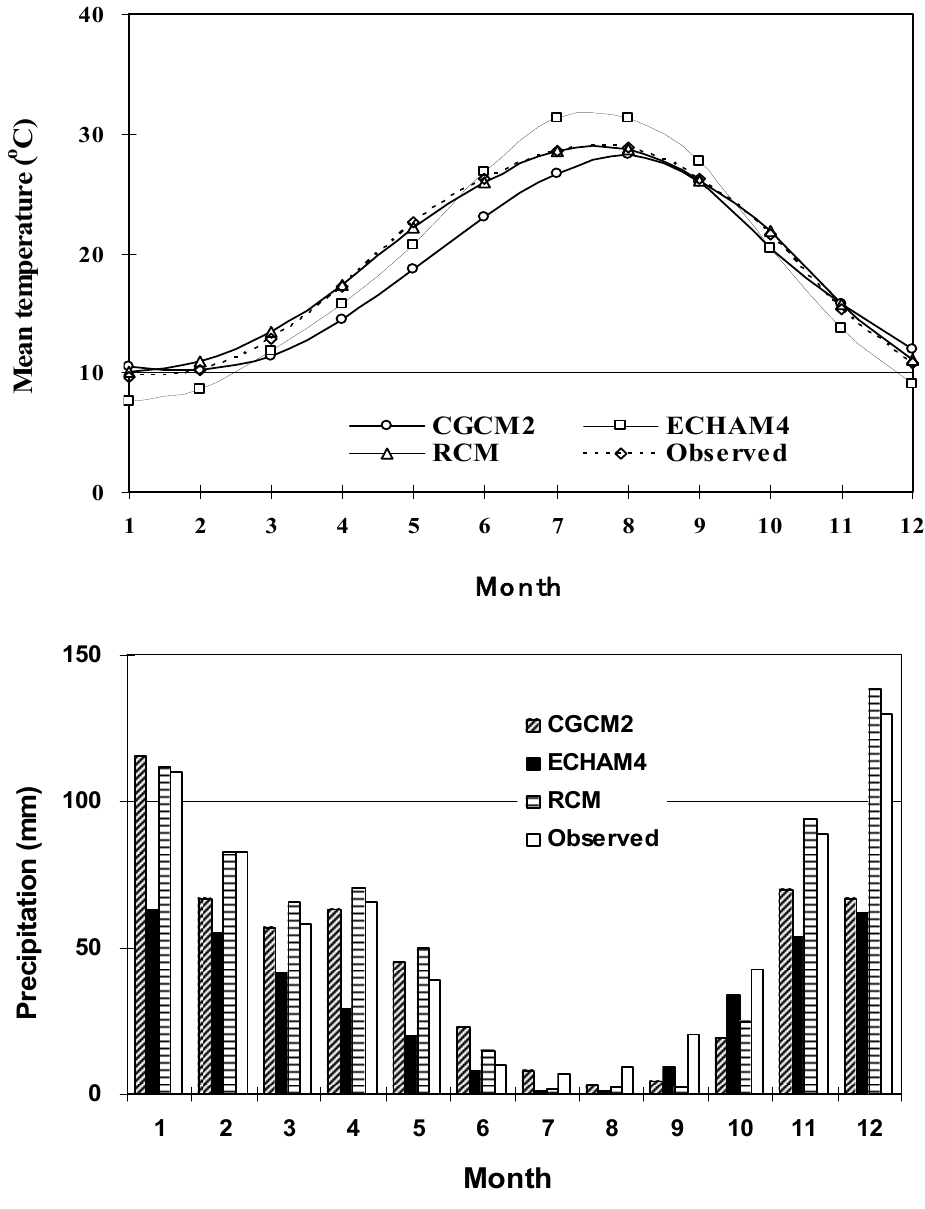
Figure 3. Comparison of monthly mean air temperature / precipitation predicted with the CGCM2, ECHAM4 and RCM models, and observed data for a period of 10 years from 1994. Monthly air temperature and precipitation predictions for Adana for the future period (2070 to 2079) based on the CGCM2, ECHAM4 and RCM models are depicted in Figure 4. As can be seen, air temperatures predicted by the models are in agreement for most of the months except for the summer months. Generally, precipitation projections of the RCM were lower than those of CGCM2 for the future period. For the A2 scenario of both GCMs, the future projections of temperature rise over the region are 2.7 o C higher than the baseline period. The increase in temperature is projected to be 1.4 o C by the RCM for the same period. Projected mean annual precipitation would decrease by 133, 56,